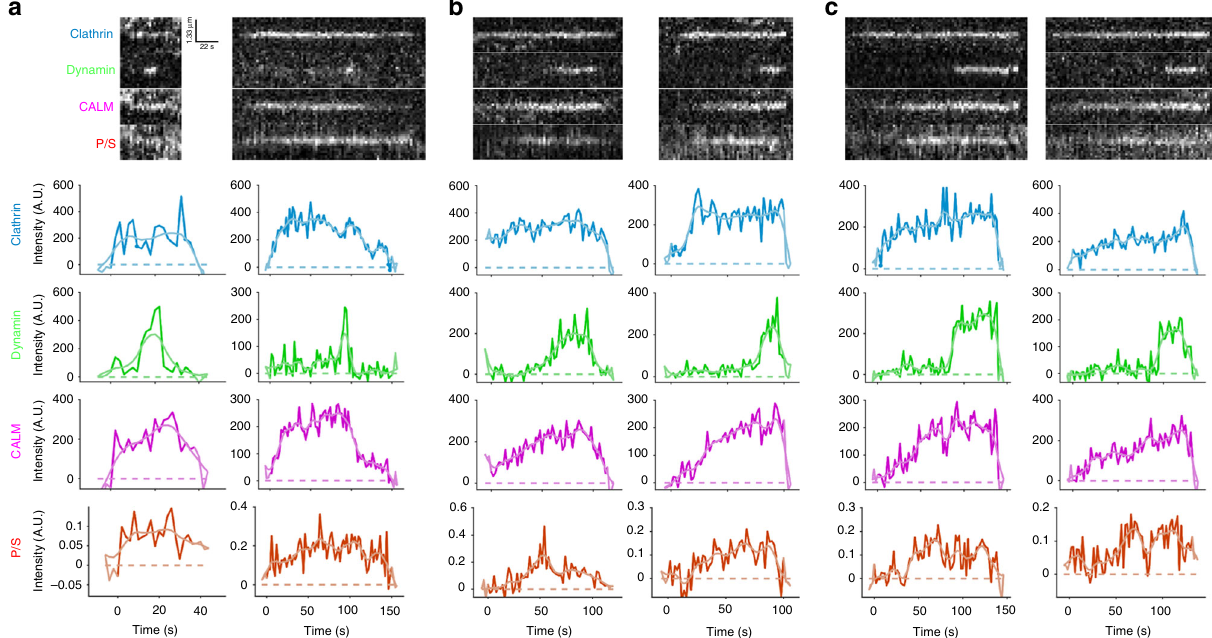
Fig. 5 CALM recruitment is highly correlated with membrane bending. a pol-TIRF kymographs and intensity traces of clathrin, dynamin, CALM, and P/S are shown for Class 1 ( a ), Class 2 ( b ), and Class 3 ( c